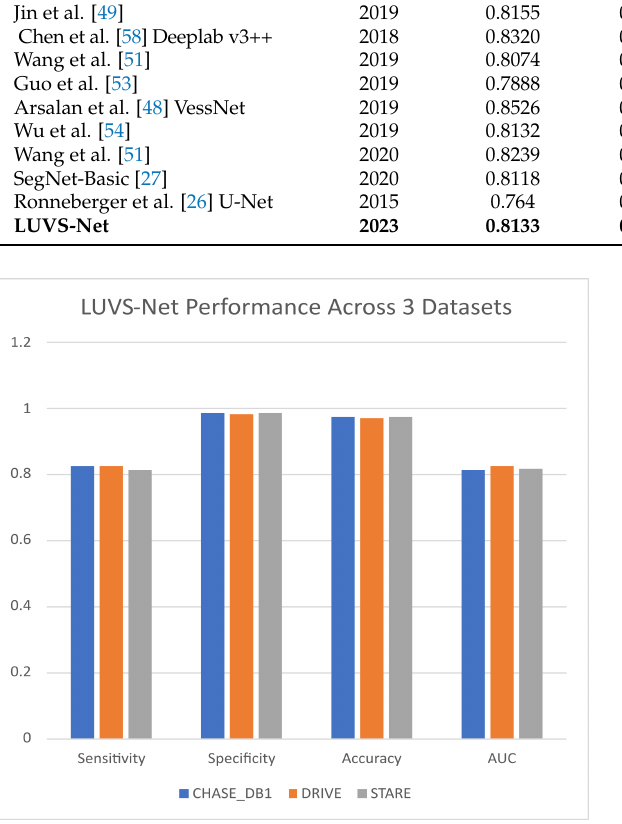
Table 7. LUVS-Net compared to existing models as tested (dataset: STARE). Method